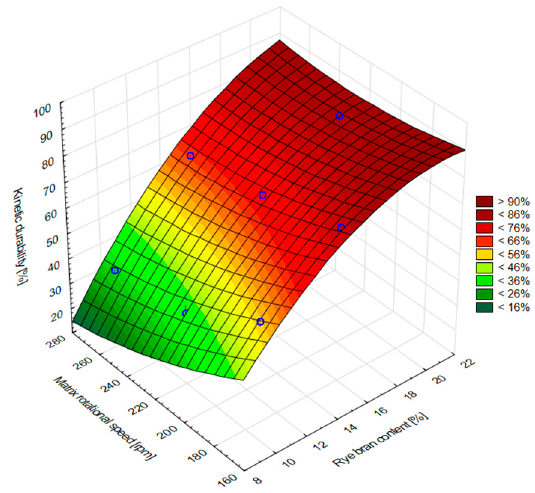
Figure 6. The impact of rye bran and rotational speed of the matrix on the kinetic durability of cherry stone granules.